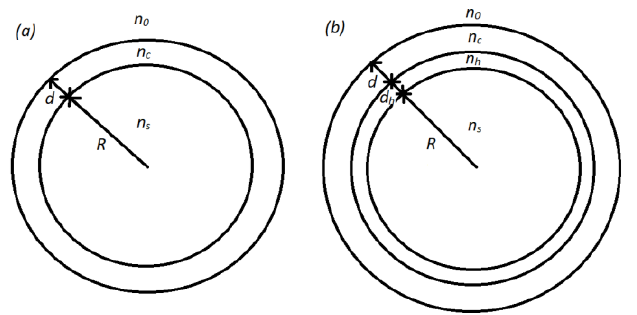
Figure 1. The sketch of a microsphere coated with a single layer ( a ) and with two layers ( b ). Spherical microresonators have mostly been used to detect analyte molecules which bond to the surface of the sphere [5 – 8]. When a molecule bonds to the surface, this can be viewed as a change of the surrounding medium the sphere is embedded in ( n 0 ). In that case, the corresponding refractometric sensitivity is equal to 𝜕𝜆/𝜕𝑛 0 [22 – 24]. In this paper, we are considering such a case when the analyte molecules can diffuse into the interior of the coating and change its refractive index ( n c ) so the corresponding refractometric sensi-